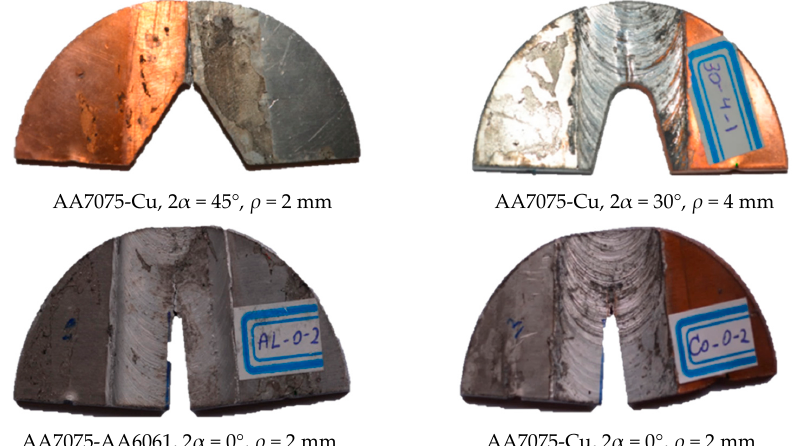
Figure 4. SCB notched samples after the pure mode I fracture test.